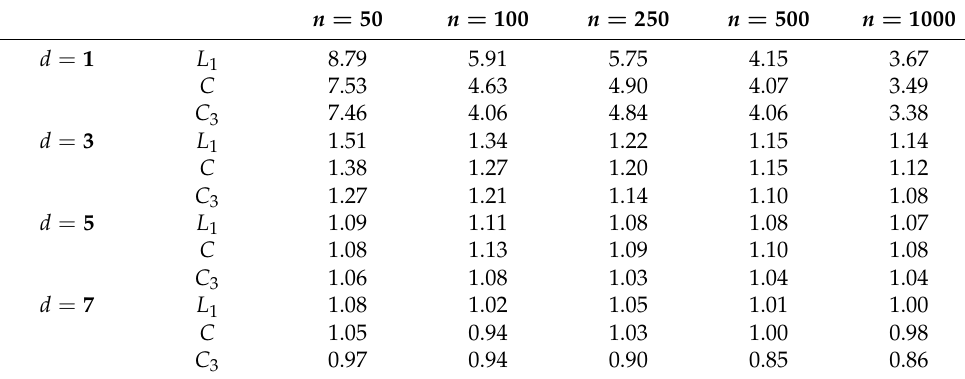
Table 1. The excess risk of the L 1 , Catoni, and third-moment Catoni regression estimator for different degrees of freedom and sample size n